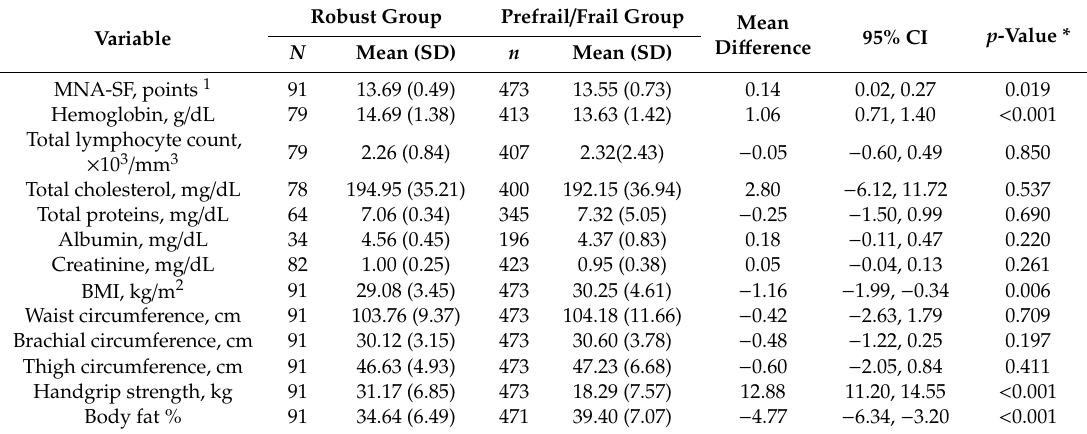
Table 3. Di ff erences between groups in nutritional